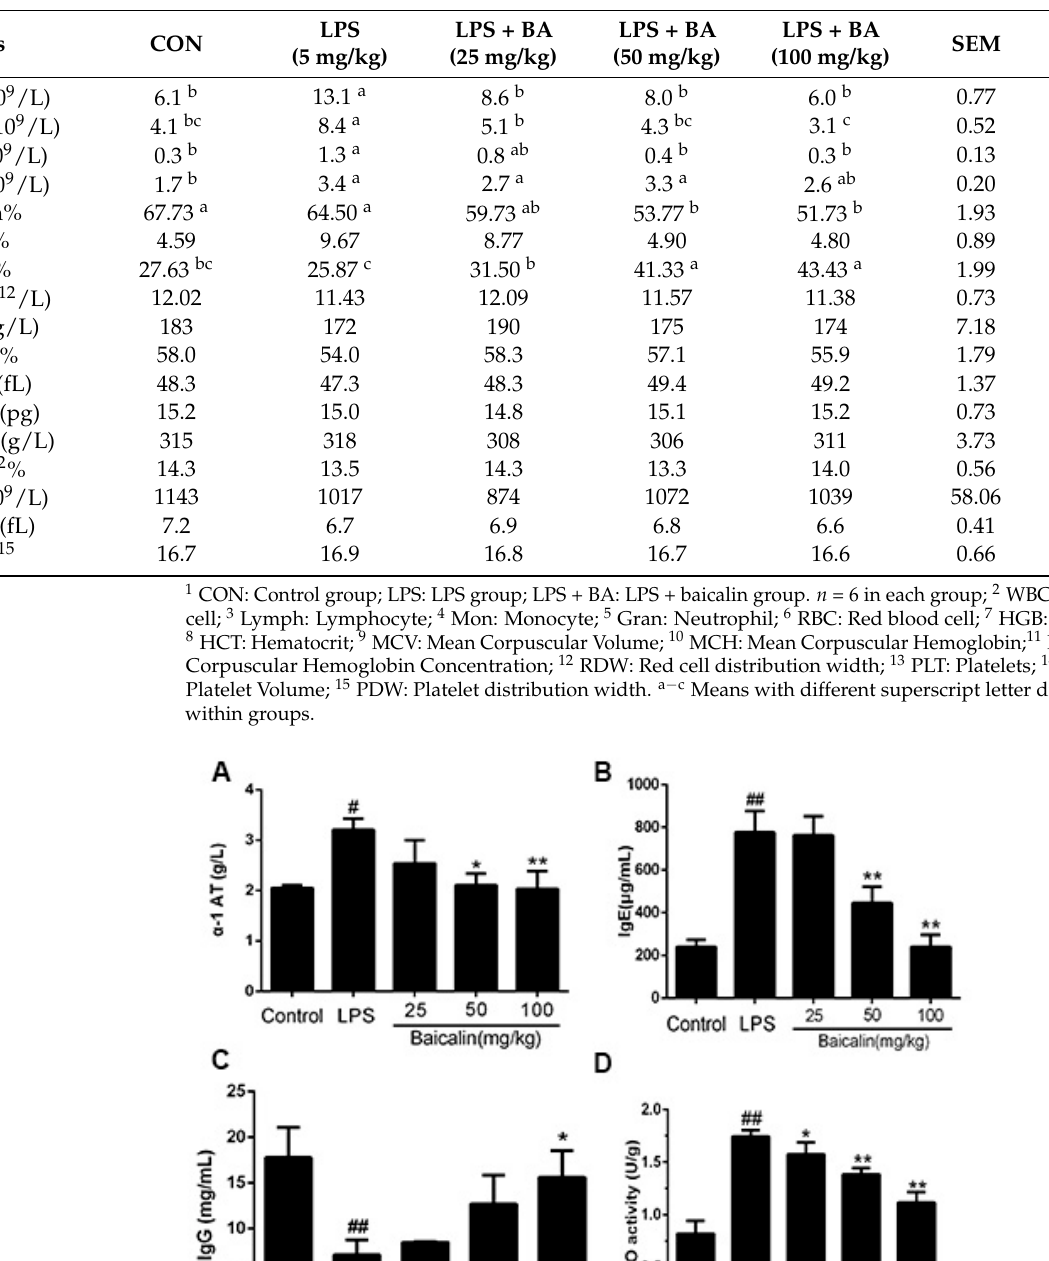
Figure 5. Effect of baicalin on lung tissue histopathological changes in LPS-induced ALI mice. LPS + baicalin group mice (n = 6 per group) were given an intraperitoneal injection of baicalin (25, 50, and 100 mg/kg) 1 h prior to LPS administration. After 6 h, 12 h, and 24 h, lungs were harvested for measuring histopathological changes. To confirm pathological changes in lung tissues, hema- toxylin–eosin (H&E) staining was performed: ( A ) Mice lung treated with LPS and baicalin for 6 h; Table 1. Effect of baicalin on the number and proportion of leukocyte cell in LPS-induced mice. ( B ) mice lung treated with LPS and baicalin for 24 h; ( C ) mice lung treated with LPS and baicalin for 12 h; the resolution was ×200. Treatment 1